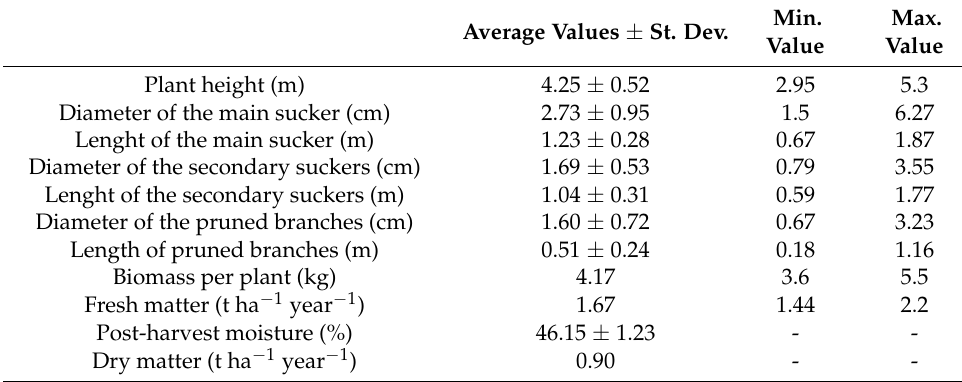
Table 2. Morphometric values of plants and dimensional characteristics of hazelnut groves pruning (Giffoni cultivar).